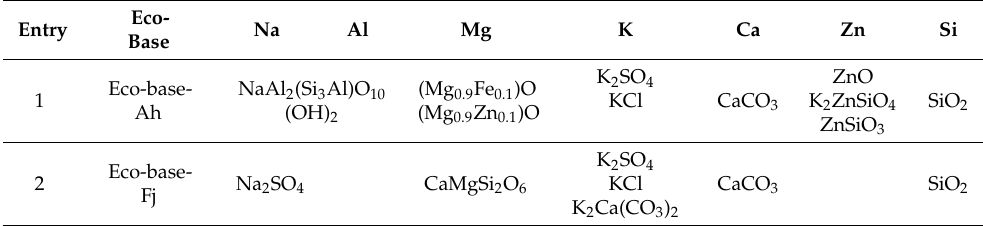
Table 3. XRPD analyses of the most promising